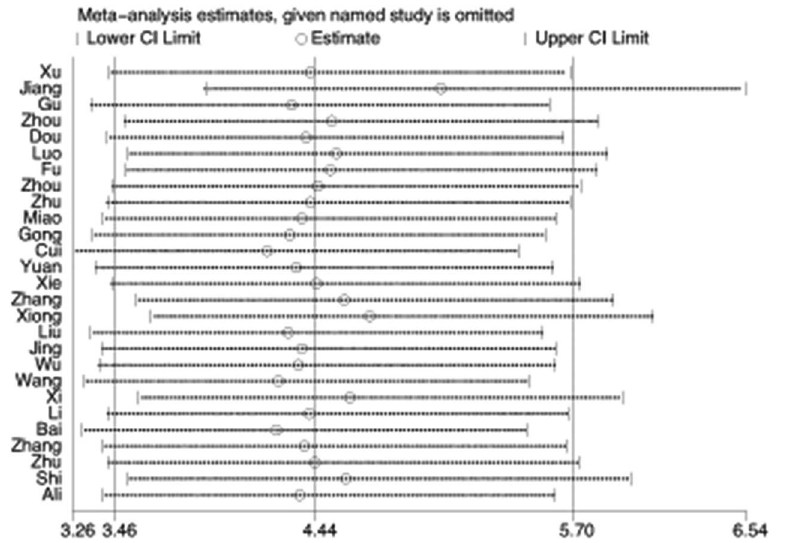
Fig 5. Sensitivity analysis to test the influences of individual studies on overall effects.